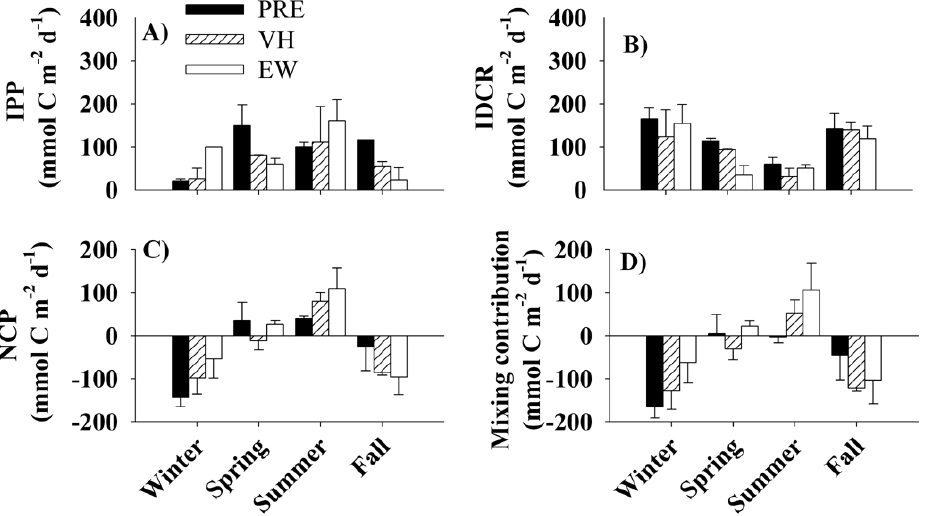
Fig. 5. Seasonal variations in (A) integrated primary production (IPP), (B) dark community respiration (DCR), (C) net community production (NCP) and (D) mixing contribution to CO 2 in the mixed layer during 2005 and 2006. IPP data were obtained from Ho et al. (2010). Error bars =± 1SD and n = 4 to